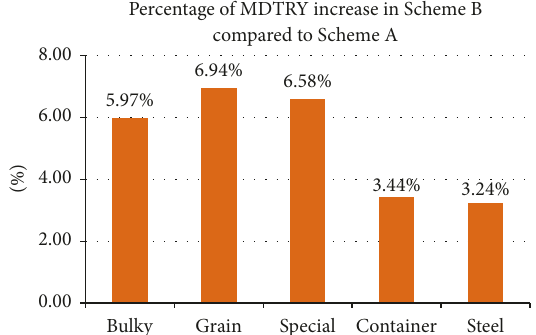
Figure 24: Differences of MDTRY between Scheme A and Scheme